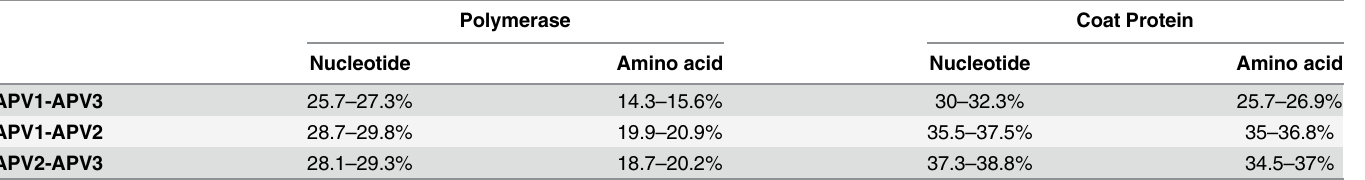
Table 2. Percentage of divergence in the polymerase and coat protein genes and deduced proteins between Asian prunus virus 1, 2, and 3